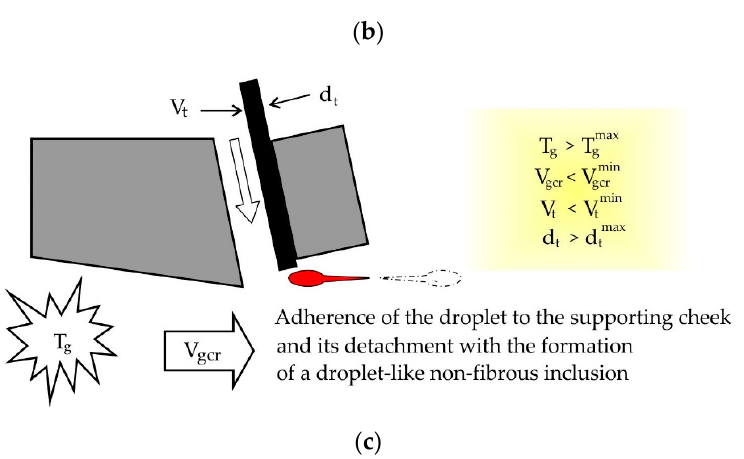
Figure 4. The process of formation of non-fibrous inclusions: ( a ) inclusions are not formed, ( b , c ) drop- Figure4. Theprocessofformationofnon-fibrousinclusions: ( a )inclusionsarenotformed, ( b , c )drop-like like inclusions are formed. inclusions are